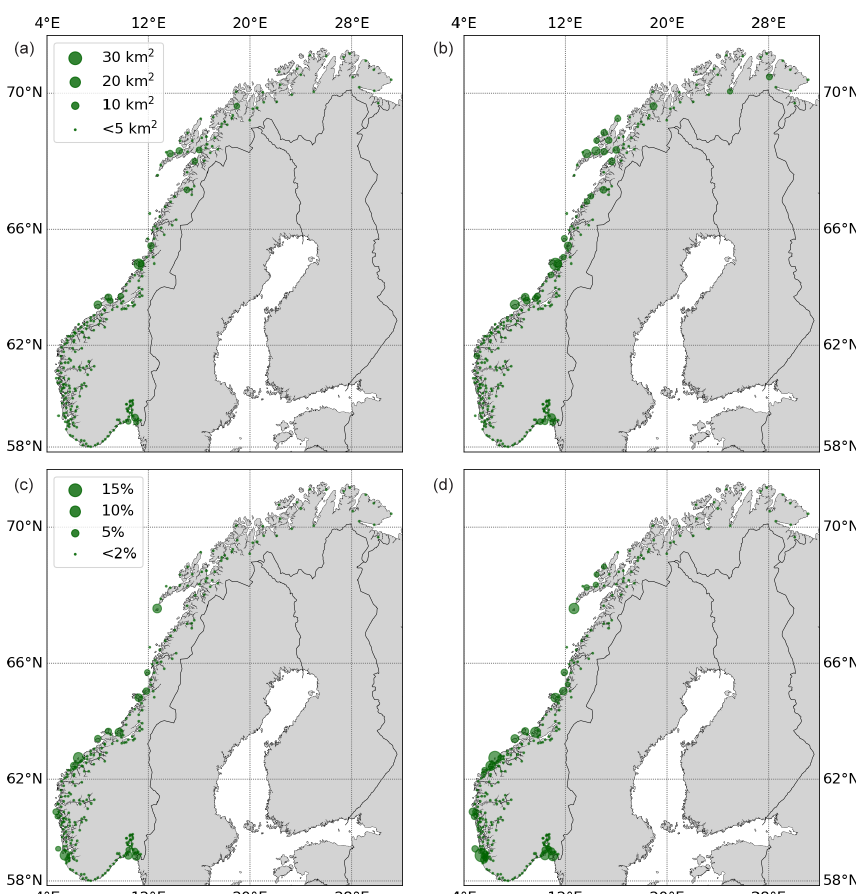
Figure 9. Affected land areas due to a 200-year storm surge hazard at present (a, c) and for 2090 (b, d) . The radius of the bubbles for each municipality is proportional to the size of flooded land area (a, b) and flooded land areas as a percentage of the municipality’s total area (c, d) .